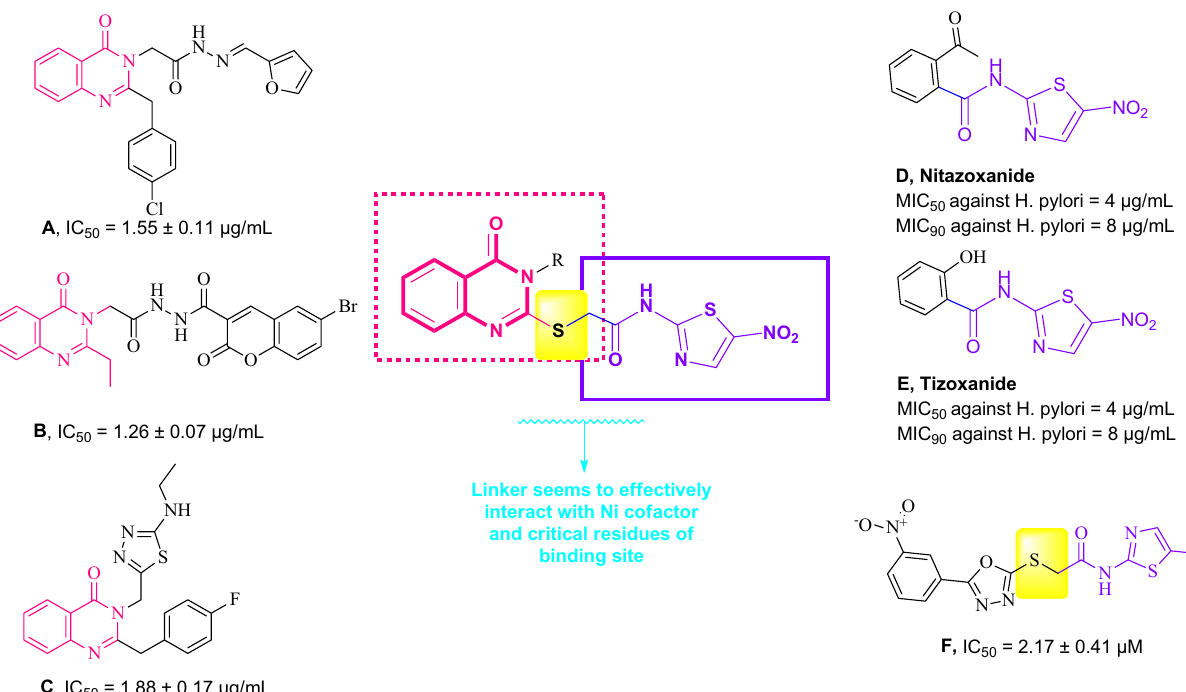
Figure 1. Chemical structures of some biologically active agents and commercial medicine against